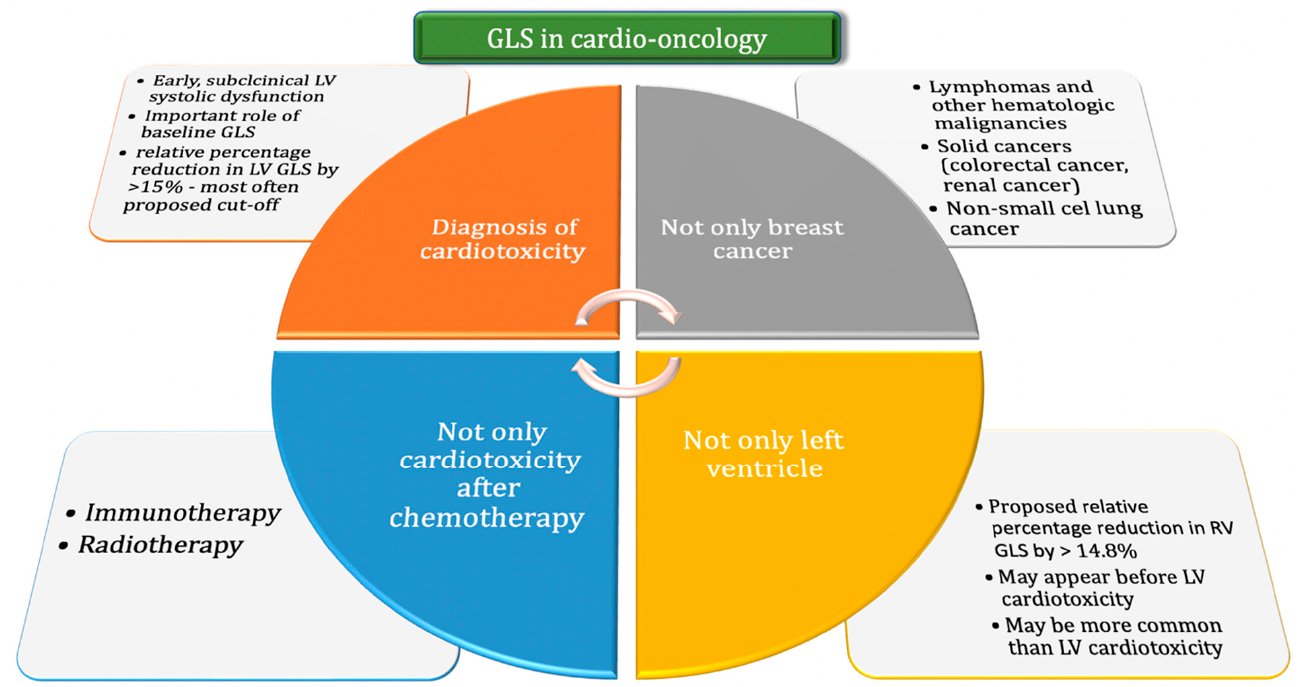
Figure 1. The use of GLS in cardio-oncology, taking into account the role of GLS in the diagnosis of cardiotoxicity, the possibility of assessing this parameters in many types of cancer and for many types of oncological treatment techniques, and the possibility of assessment also for the right ventricle. Abbreviations: GLS = global longitudinal strain; LV = left ventricular; RV = right ventricular.